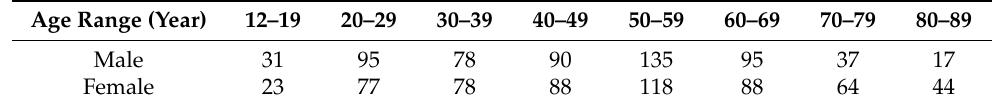
Table 2. Gender and age distribution of the respondents.